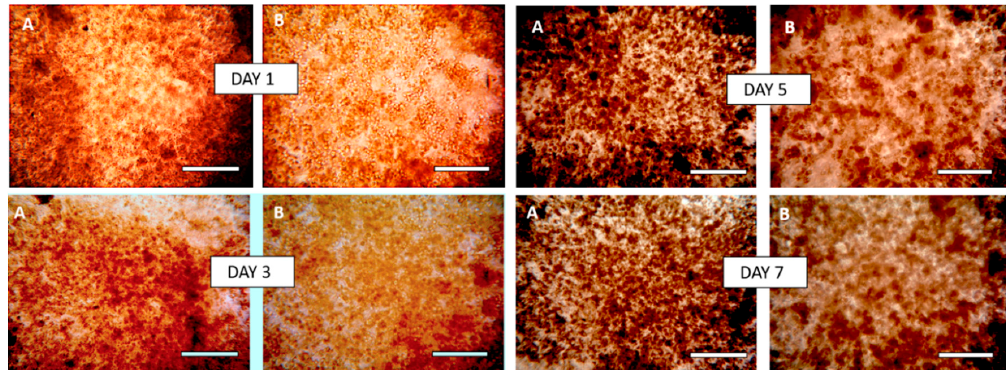
Figure 8. Bright field optical microscope images of HaCaT clusteroids isolated by a dilution of the DEX/PEO emulsion by a factor 3 with DMEM medium and incorporated with 0.75 wt% sodium alginate in DMEM media followed by cross-linking with 1M CaCl 2 . The HaCaT cells clusteroids were cultured in the alginate film for seven days under DMEM media and images were taken from each well to determine the average clusteroids size. Scale bars are 200 μ m ( A ) and 100 μ m ( B ) images. Clusteroids average size evolution is summarized in Figure 9. Biomimetics 2019 , 4 , 50